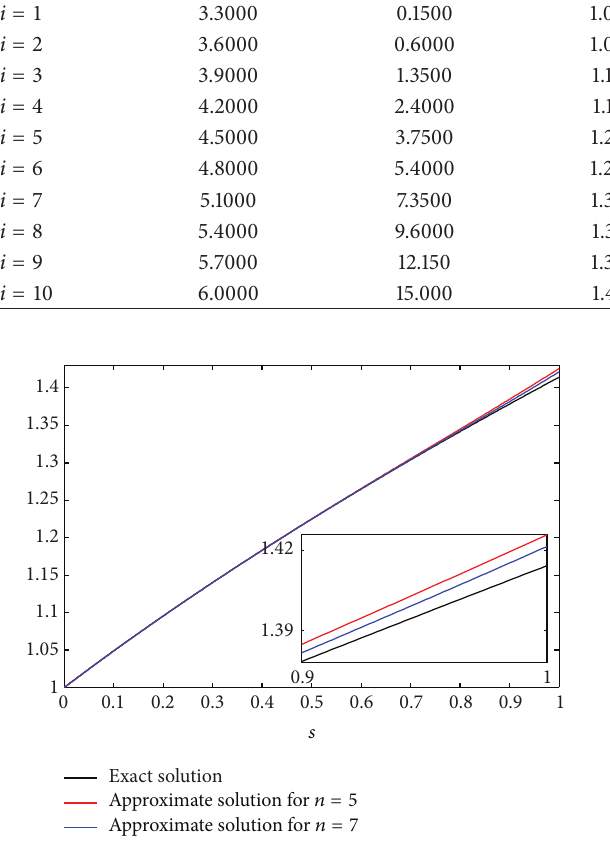
Figure 2: 𝜑 3 (𝑠) , 𝜑 3,3 (𝑠) , and 𝜑 3,5 (𝑠) for Example 3.